Question: Author a descriptive caption for the visualization shown.
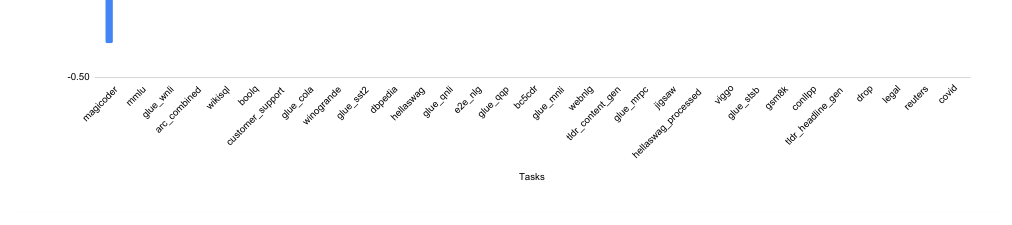
Answer: Performance lift from the best fine-tuned LLM over 1) the best base model (<= 7B) (in blue) and GPT-4 (in red) across 31 tasks, in absolute points.